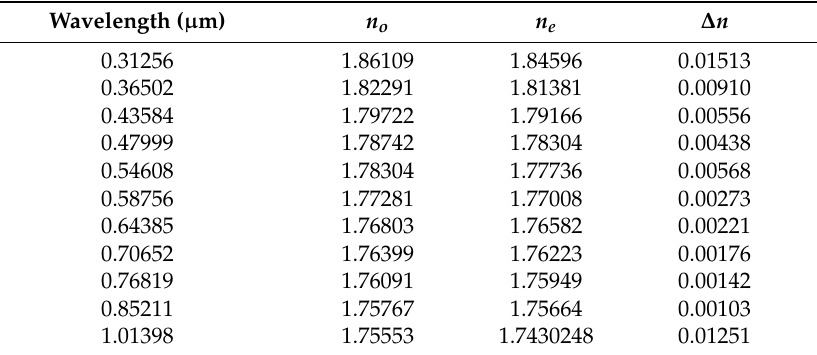
Table 1. The refractive indices of BTS crystal measured at different wavelengths.